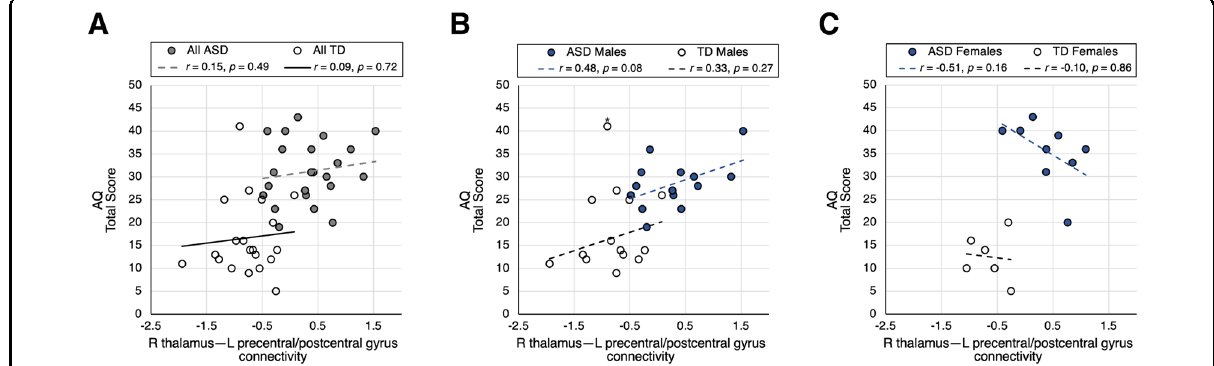
Fig. 2 Correlations of left precentral/postcentral gyri cluster with AQ. Correlations by group ( A ), in males by group ( B ), and in females by group ( C ). Reported r values are Pearson ’ s correlation coef fi